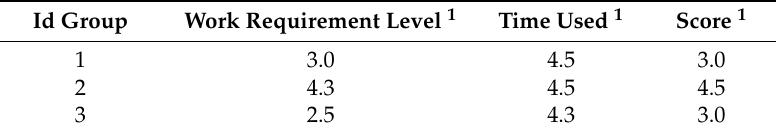
Table 5. Relation among work requirement level, time used and the final